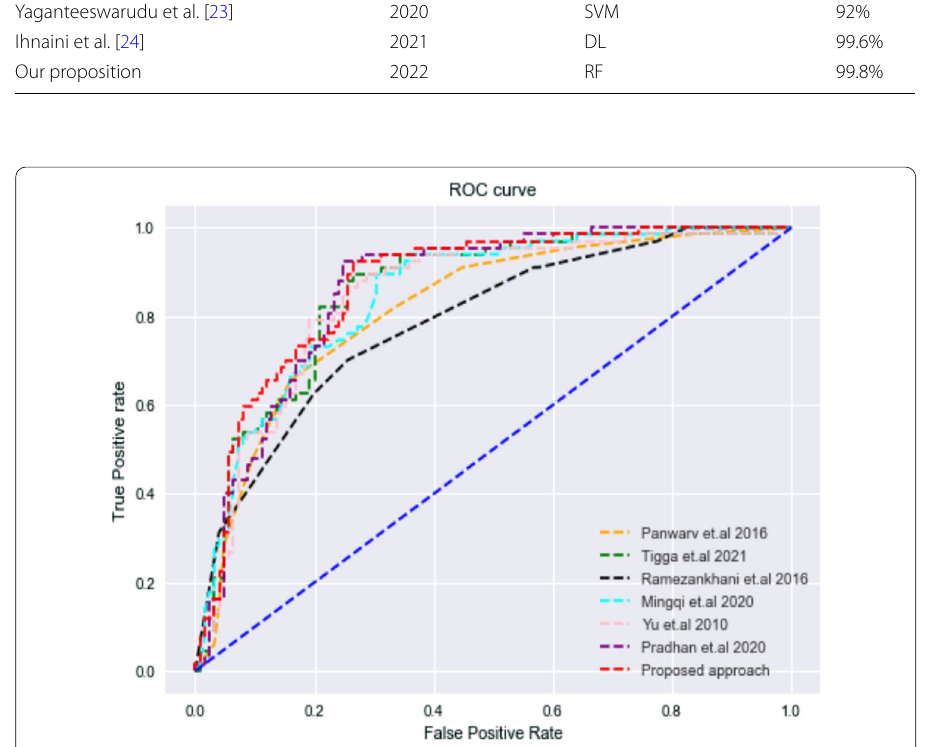
Fig. 18 A comparison of different ML